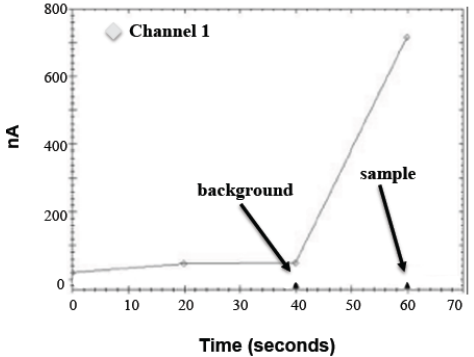
Figure 1. Amperogram (screenshot) of a typical PHAD (Portable Hazardous Agent Detector) instrument run. All the data presented here was obtained while the PHAD instrument was in run. All the data presented here was obtained while the PHAD instrument was in single-channel mode, single-channel mode, i.e. Channel 1 in the sample above. i.e., Channel 1 in the sample